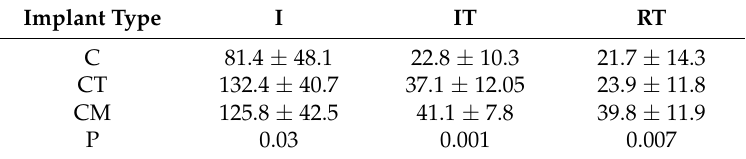
Table 4. Average I, IT, and RT values for each implant types and significance p of the ANOVA tests comparing them. A significant difference among the three implants can be observed for all three implant primary stability parameters under investigation. Values reported in this table are also shown as plots in Figure 5, together with the corresponding significance of paired